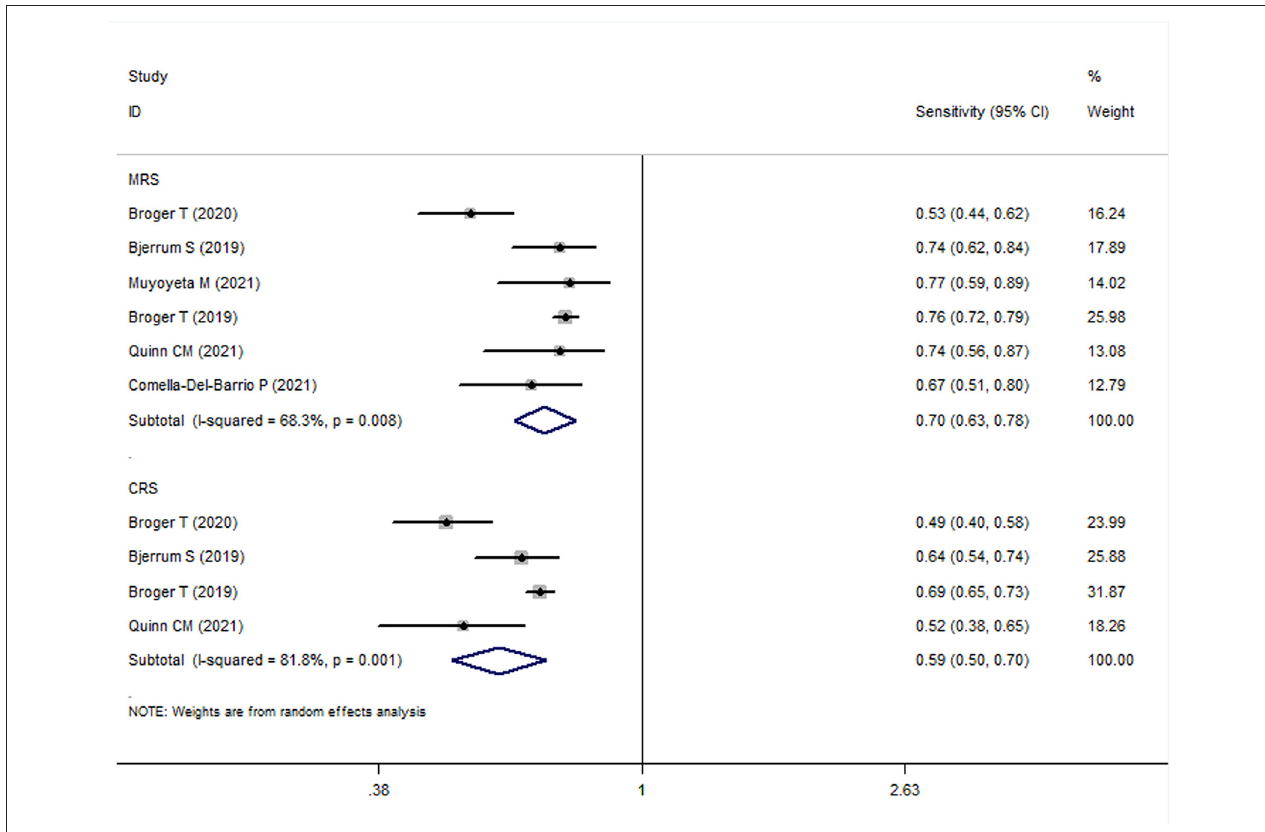
FIGURE 3 | The meta-analysis results of the sensitivity of FujiLAM in the diagnosis of adult patients with